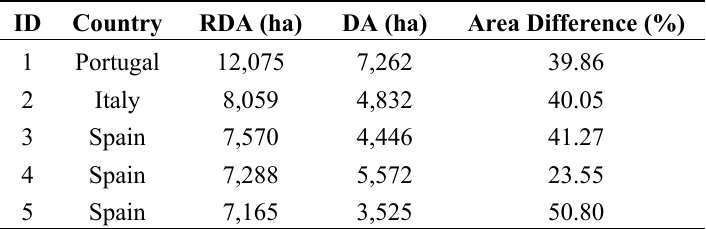
Table 1. Comparison of burned area estimates for the five largest forest fires in Mediterranean Europe in 2009 between MODIS-based European Forest Fire Information System Rapid Damage Assessment (EFFIS-RDA) and Advanced Wide Field Sensor (IRS-AWiFS)-based burned scar